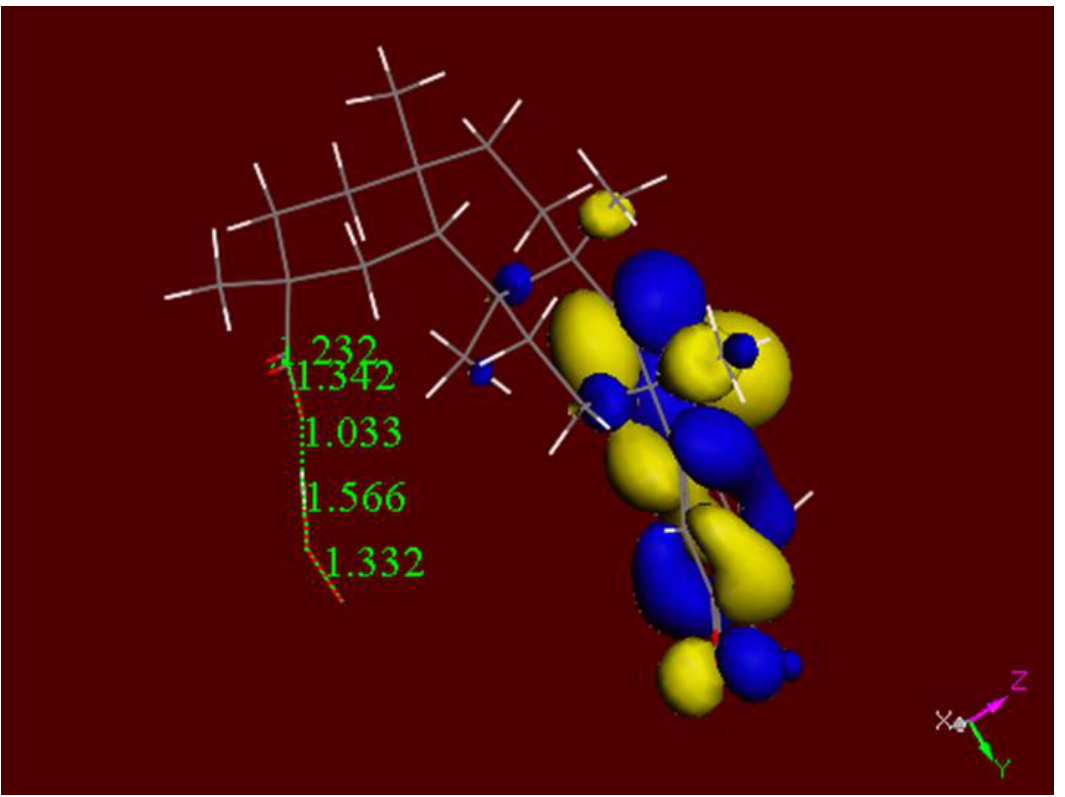
Figure 12. LUMO for the complex celastrol-carboxylic-moiety-superoxide, total charge −1. LUMO indicates further reactivity in the methide quinone area of this complex.